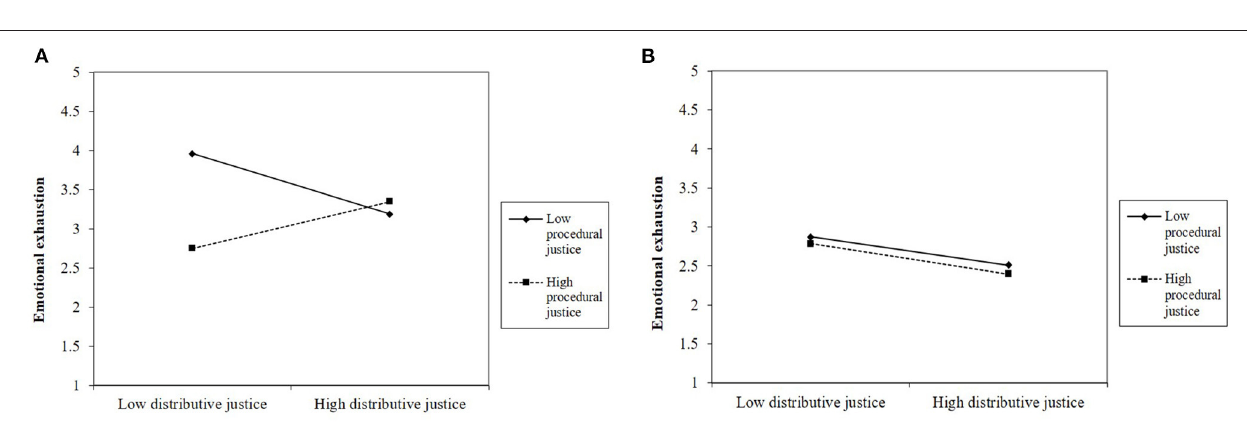
was in the expected direction, but it did not reach significance for job satisfaction ( B = 0.04, SE = 0.04, p =